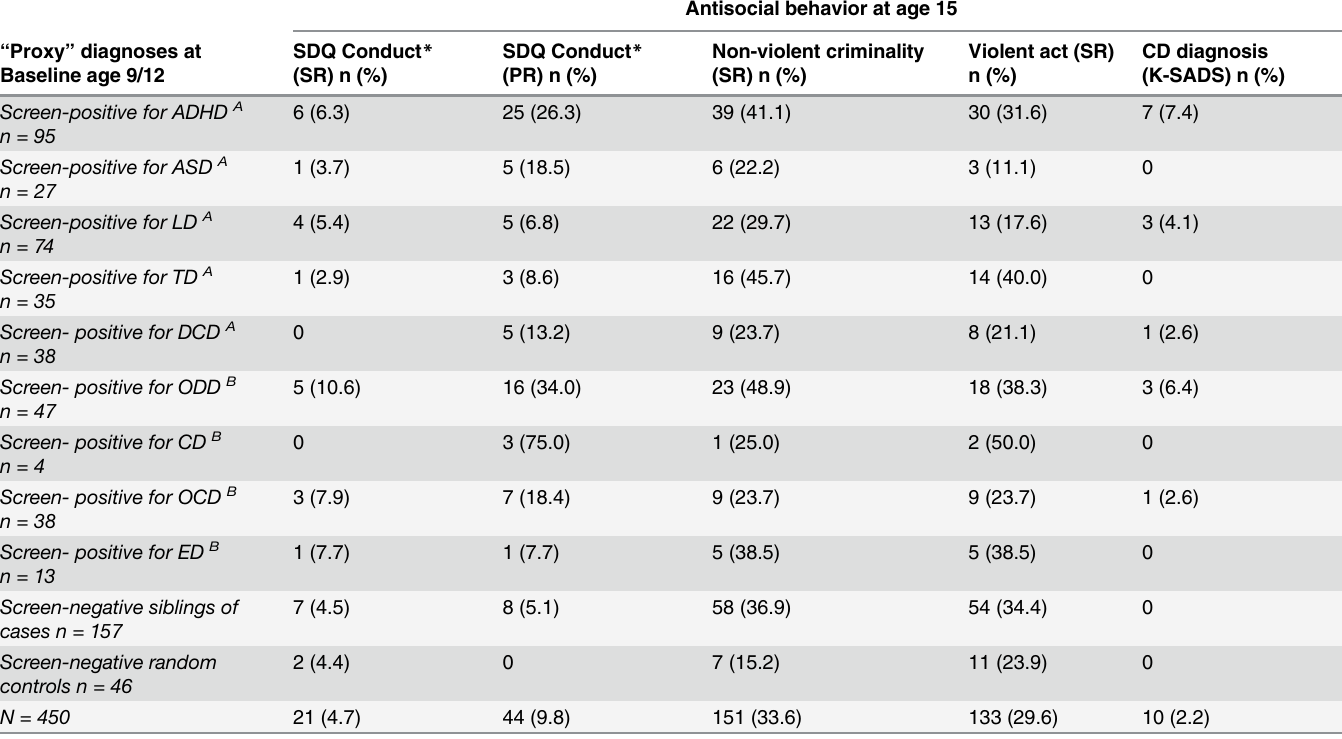
Table 4. Frequencies of subcategories of the outcome antisocial behavior (see Table 3, column 4) for screen-positive cases, screen-negative sib- lings, screen-negative controls, and the whole cohort at age